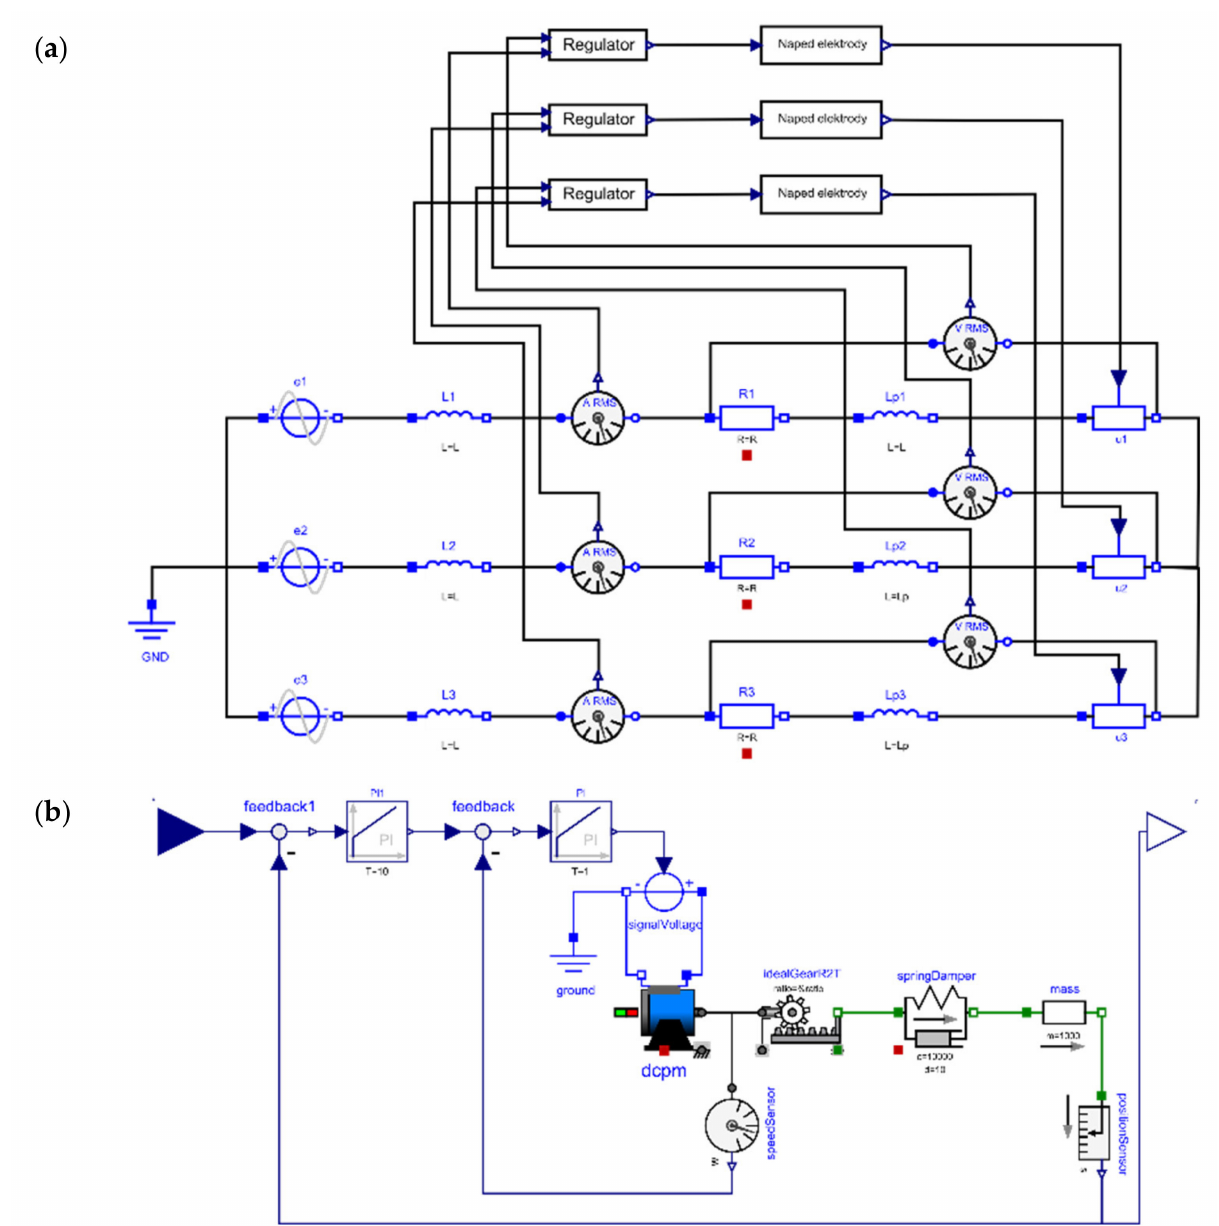
Figure 5. Electric arc furnace model created using Modelica language: ( a ) high current circuit, ( b ) electrode control system. Source: